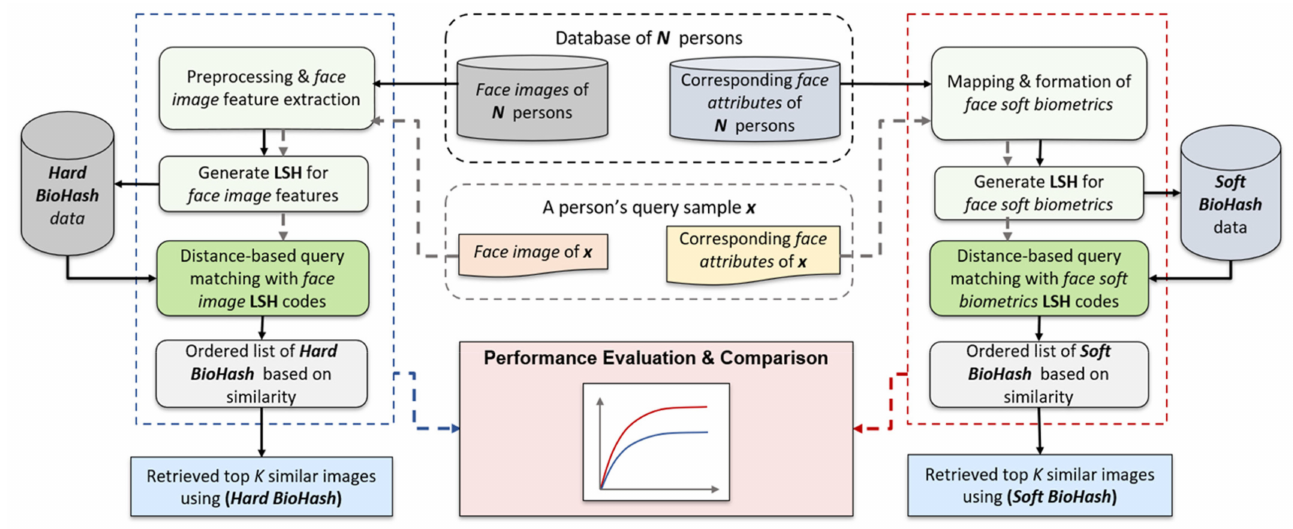
Figure 4. Overview of the proposed methodology.